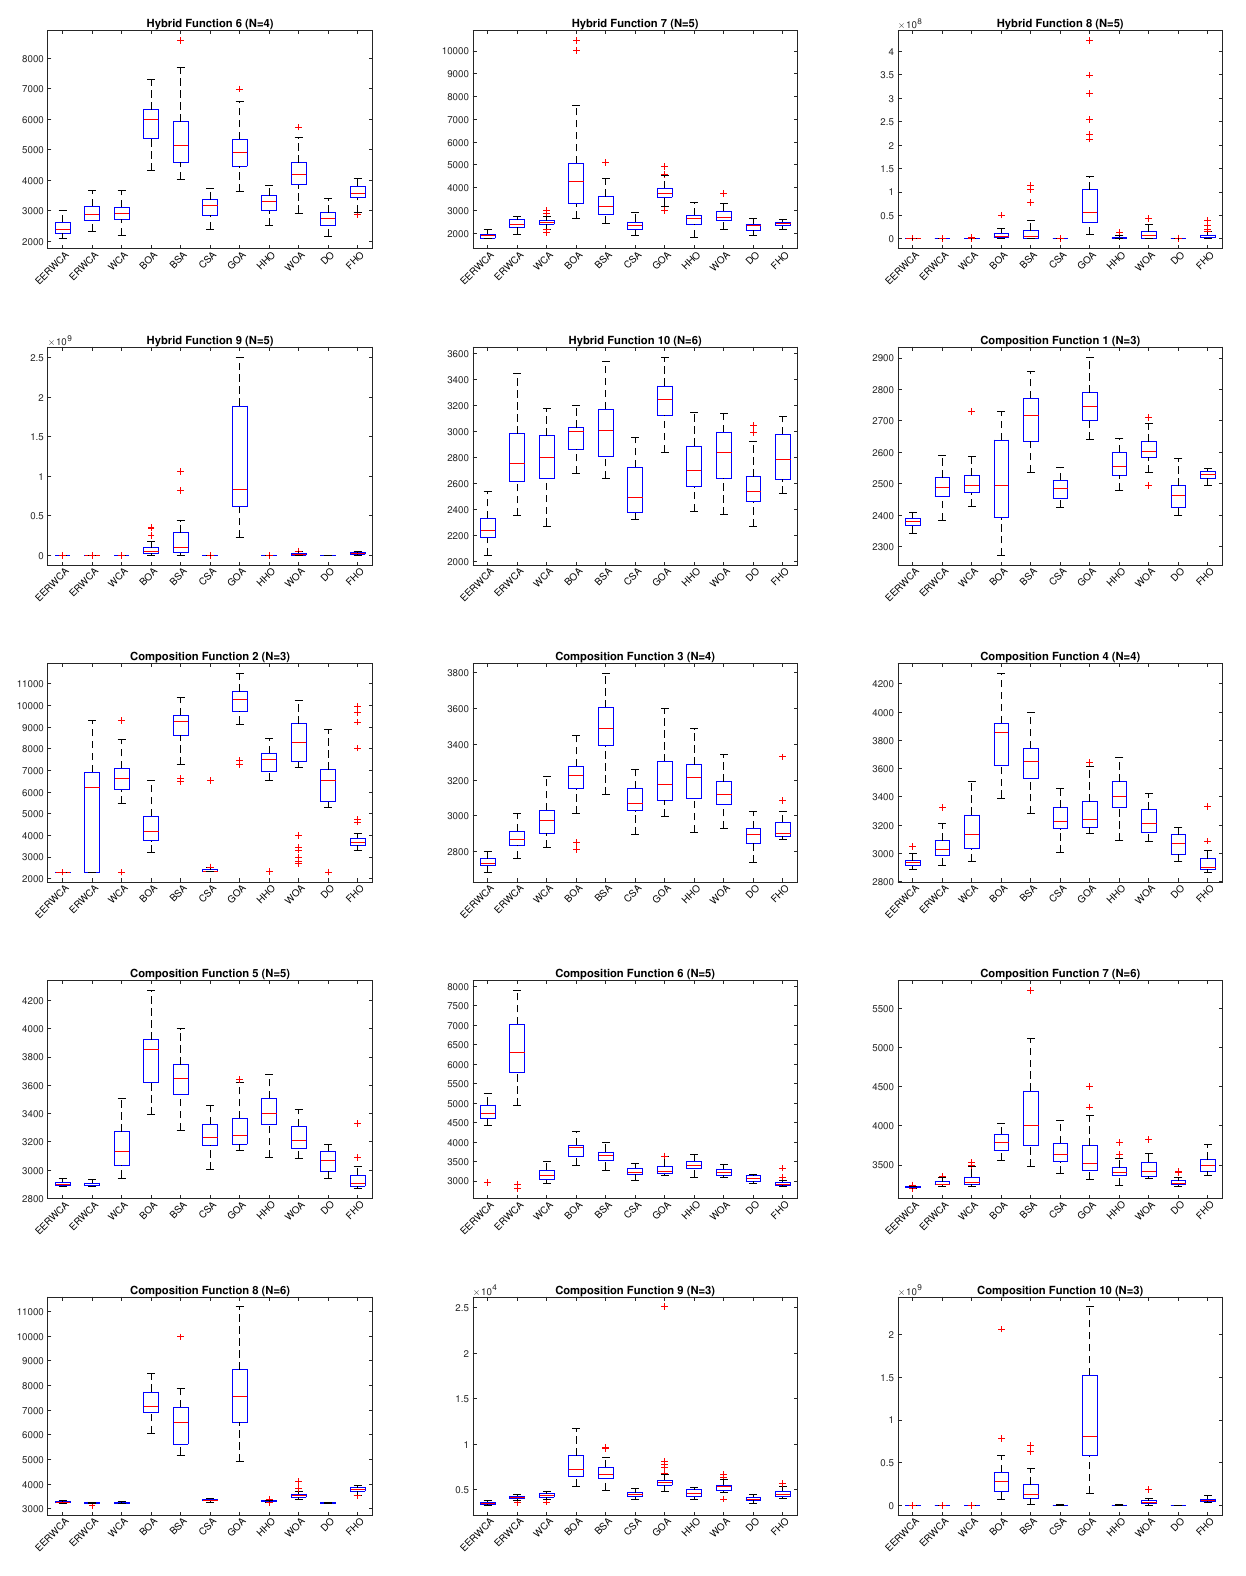
Figure 5. Box plots of some functions from F16–F30 for all algorithms using CEC2017 and dim =